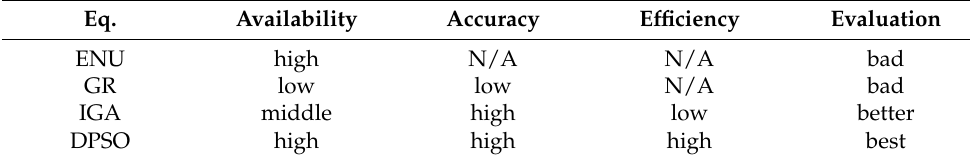
Table 10. Comparison of advantages and disadvantages of multiple algorithms.